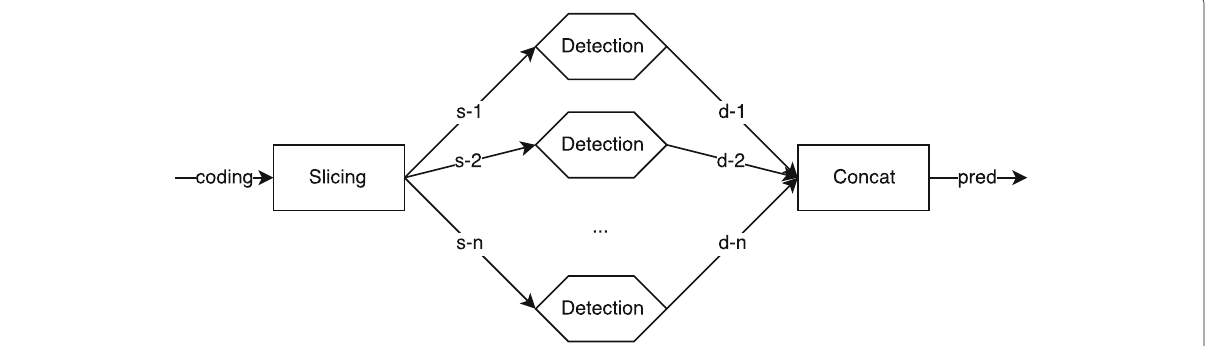
Fig. 5 Structure of “DMP.” Legends can be referred to Fig. 1. All built-in layer names conform to Caffe. Details can be referred to Section